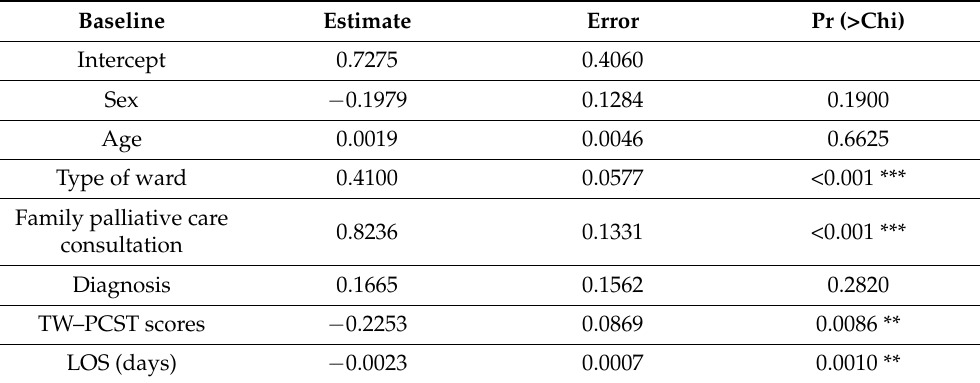
Table 3. Significance of variables in the logistic regression for DNR